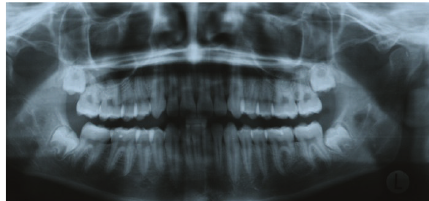
Figure 1: Initial panoramic radiograph.